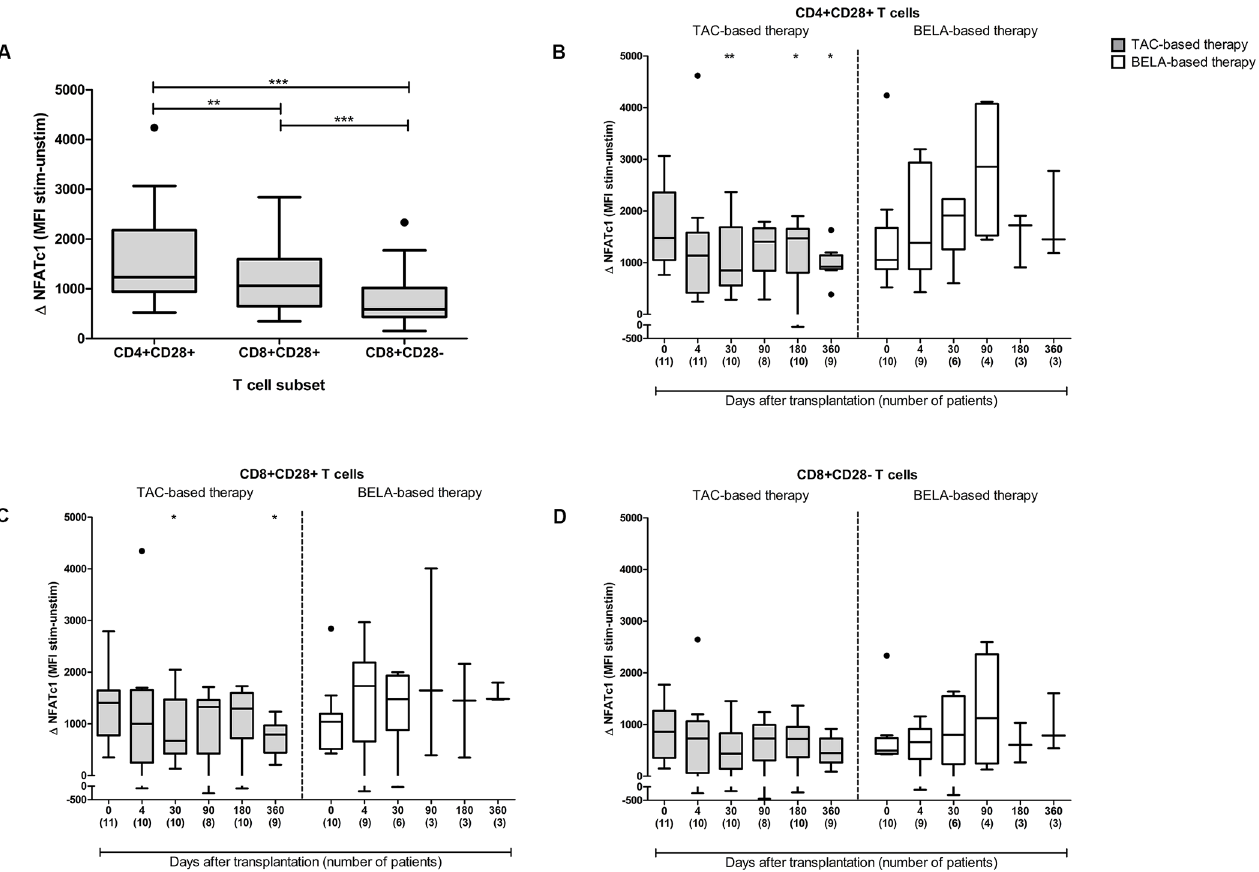
Fig 4. Immunosuppressive drug therapy effects on NFATc1 amplification in T cell subsets. (A) NFATc1 amplification in CD4 + CD28 + , CD8 + CD28 + and CD8 + CD28 - T cells before transplantation (n = 21 kidney transplant patients). (B, C, D) Inhibition of NFATc1 amplification (MFI) after a TAC-( grey )or BELA-( white ) based therapy. Delta NFATc1 expression (amplification) was determined at different time points after transplantation and compared to the samples before transplantation in CD4 + CD28 + (B), CD8 + CD28 + (C) and CD8 + CD28 - T cells (D). The number of patients that were measured at each time point is shown on the x-axis in parentheses. n = 11 TAC-treated patients and n = 10 BELA-treated patients at day 0. Data are plotted as box and whiskers (Tukey style); (cid:3) ) p < 0.05, (cid:3)(cid:3) ) p < 0.01 compared to day 0.